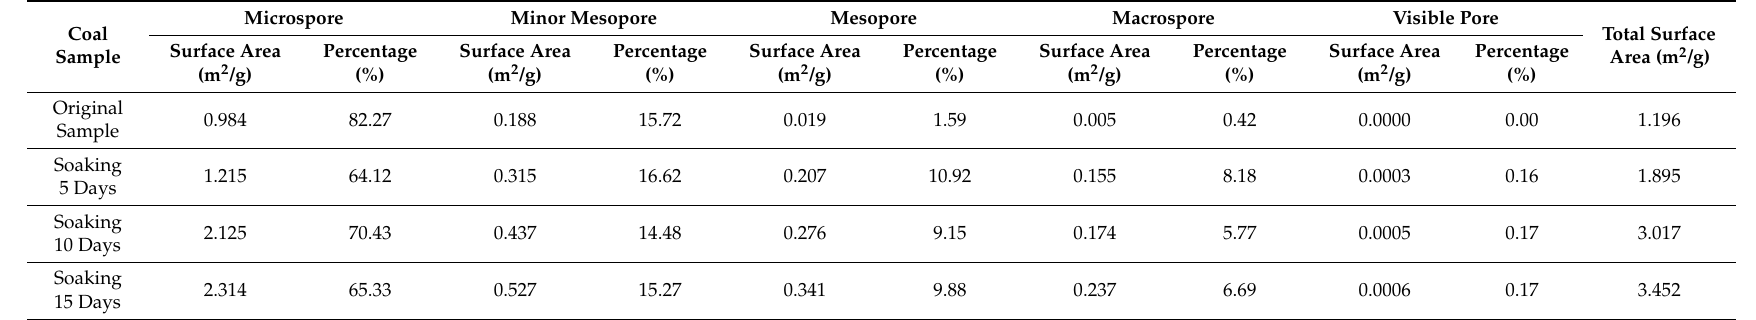
Table 5. The distribution of pore surface area of coal